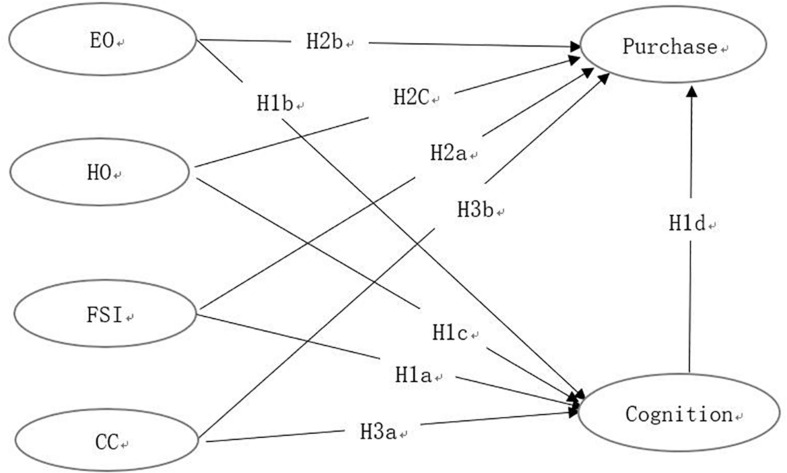
Research framework.